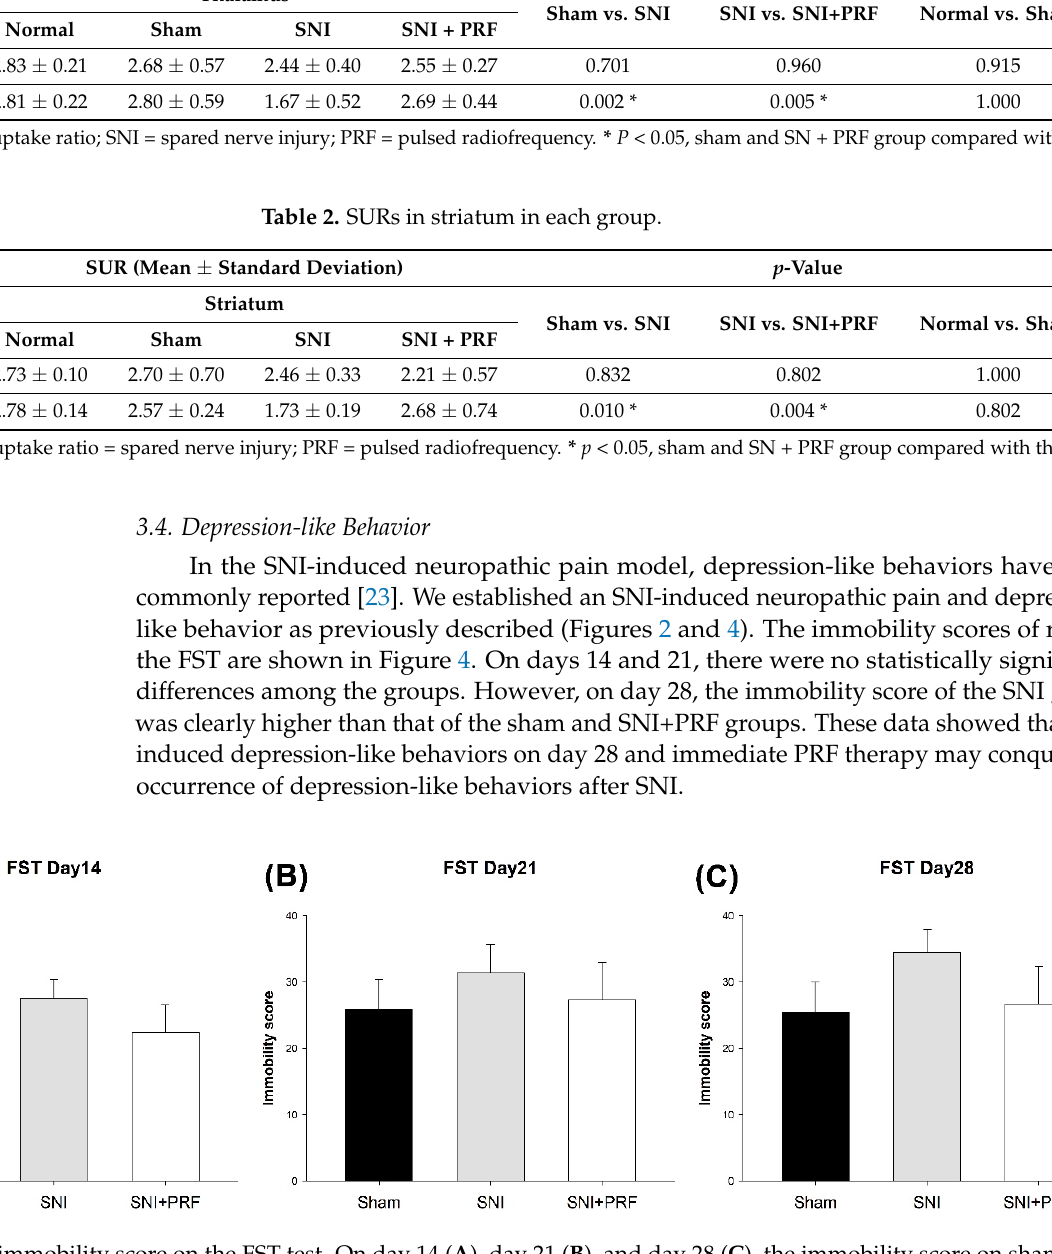
Figure 5. Expression of proinflammatory cytokines in serum at baseline, day 1, day 15, and day 29. The levels of (A) IL- 1 β , (B) TNF- α , and (C) IL-6 in serum of sham operation, SNI without PRF, and SNI plus PRF rats. Data are expressed as the mean ± SD. *p < 0.05 compared to the SNI group, **p < 0.01 compared to the SNI group, ***p < 0.001 compared to the SNI group. n = 5 in each group. 4. Discussion This is the first study to explore the effects of PRF on SERT uptake using micro-PET brain images in a model of SNI-induced neuropathic pain and despair-like behaviors. In this study, we found that SNI induced long-lasting mechanical allodynia, cold allodynia, and consequent depression-like behaviors on day 28. We also demonstrated that SERT expression in the SNI neuropathic pain rat model was reduced in brain regions of the thalamus and striatum on day 28. Our results further support the use of PET imaging as a valuable diagnostic tool to reflect the impact of severe neuropathic pain on brain reor- ganization. Immediate PRF therapy after nerve injury exhibited a pronounced increase in SERT uptake measurements in the thalamus and striatum compared to the measurements in the SNI group on the 28th day. Additionally, PRF treatment reduced pain behaviors in the mechanical and cold allodynia tests and improved depression-like behavior in the FST compared to rats in the SNI group. Moreover, we further found that proinflammatory cytokines significantly increased serum IL-1 β and TNF- α levels on the first day, and a pronounced increase in IL-6 was noted on day 29. However, after immediate PRF therapy